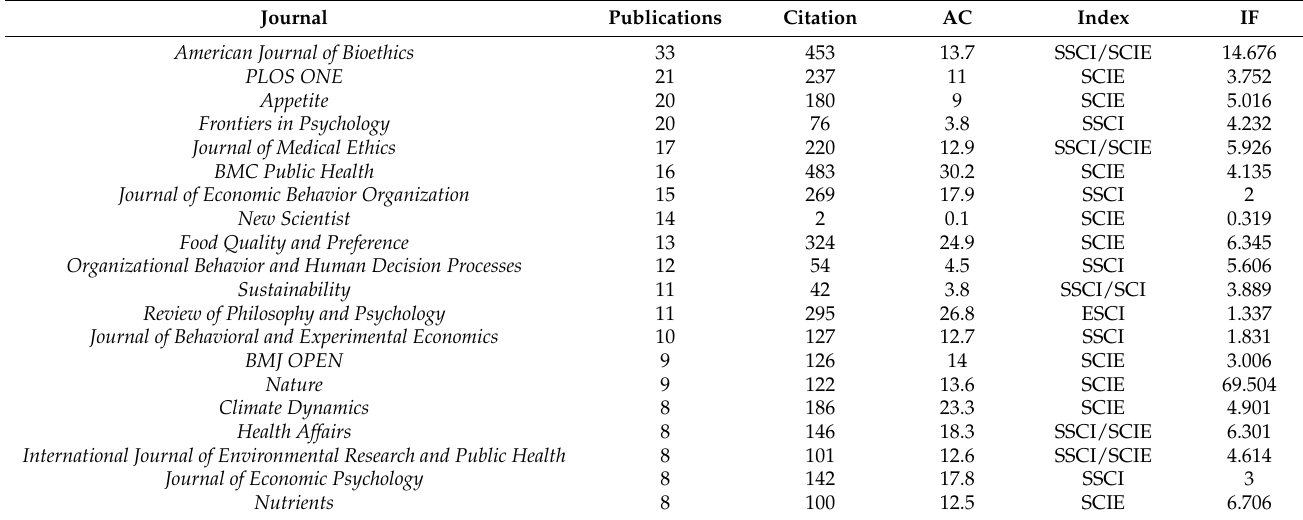
Table 3. Top 20 most productive journals.